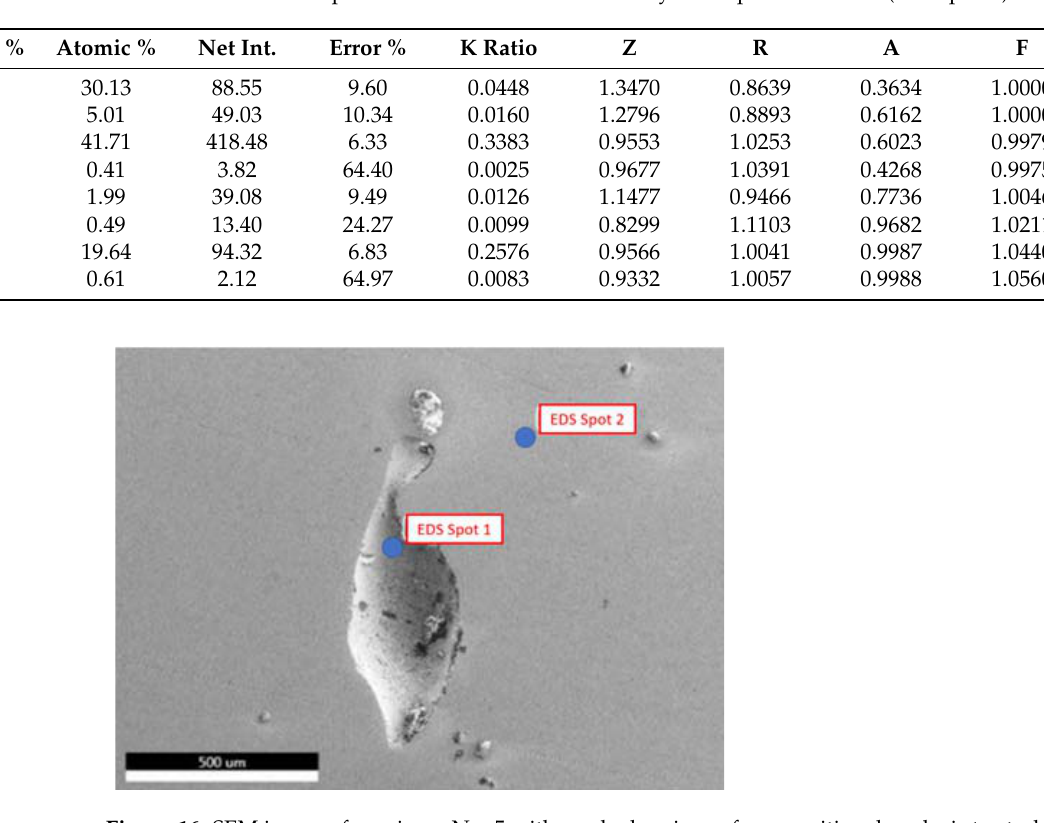
Figure 15. EDS measurement of the third point for specimen No. 5. Table 7. Chemical composition as the result of EDS analysis in specimen No. 5 (third point).